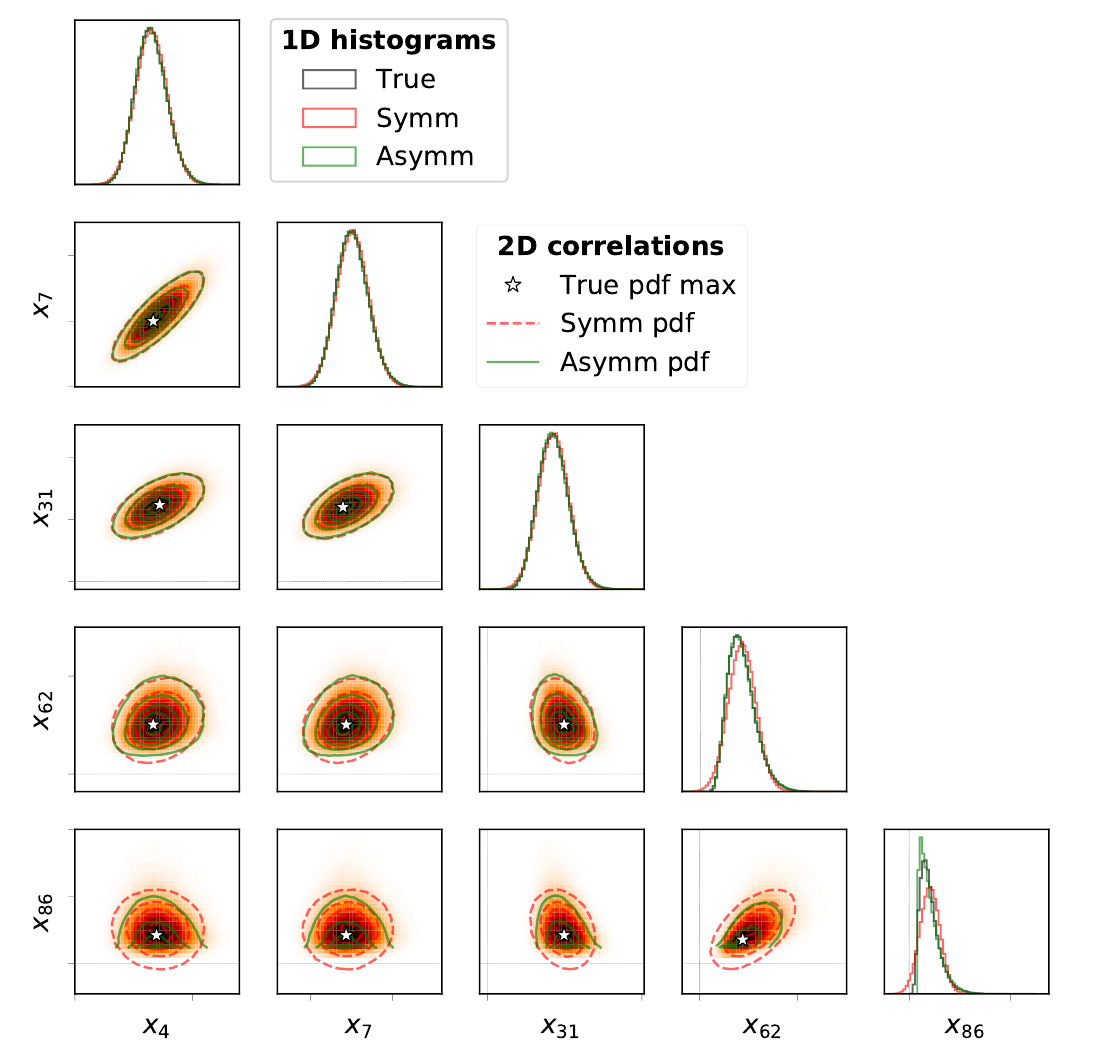
Figure 4 . 2D distributions of ^ n against ^ n for the LHC-like experimental pseudo-search as b;I b;J described in the text. The background heat map is generated from 100,000 samples from the true model, the dashed red contours from the symmetric SL, and the solid green contours from the asymmetric SL. The diagonal panels show the 1D distribution in each of the bins for the toys (black histograms), and the symmetric (red histograms) and asymmetric (green histograms) SLs. In the pair of high-statistics bins in the top-left plot, clear agreement is seen between the symmetric and asymmetric SLs; in the top-right, deviations start to appear, and in the low-statistics bin J = 86 of the bottom plot the asymmetry is seen to become very signi(cid:12)cant, and the symmetric SL form has a signi(cid:12)cant probability density fraction in the negative-yield region.